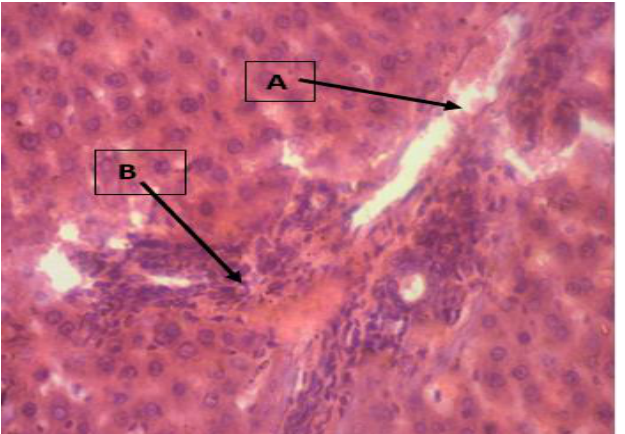
Fig. 5. Photomicrograph of rat kidney showing glomeruli (A) and tubules (B) [Control Group 10 X].